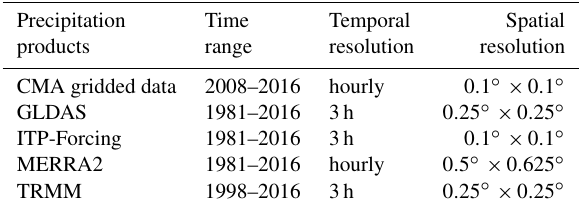
Table 1. The precipitation products used in this study. Precipitation Time Temporal Spatial products